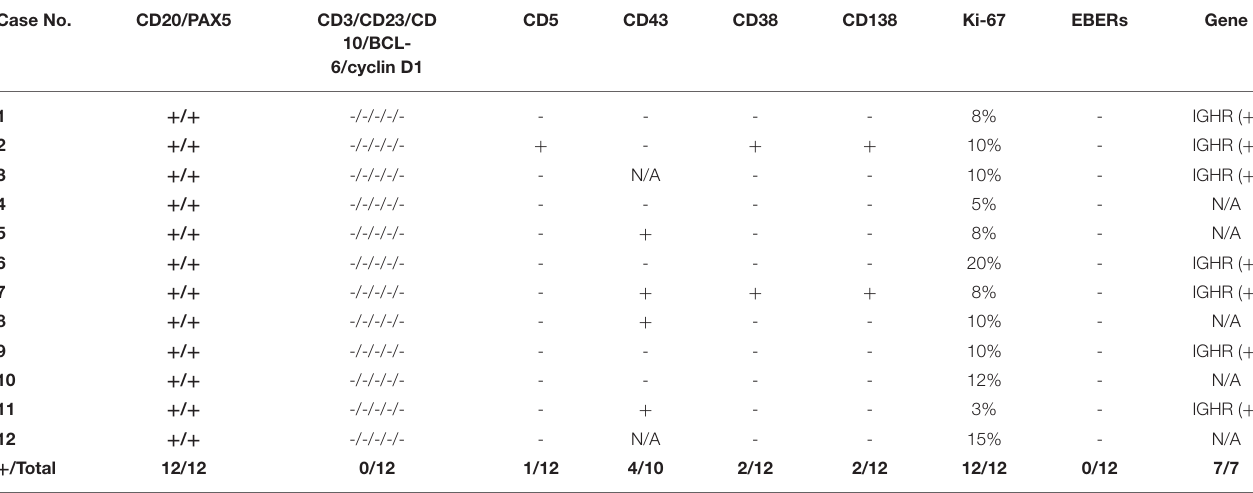
TABLE 2 | Immunophenotype and gene alterations of the 15 cases with thymic MALT lymphoma. Case